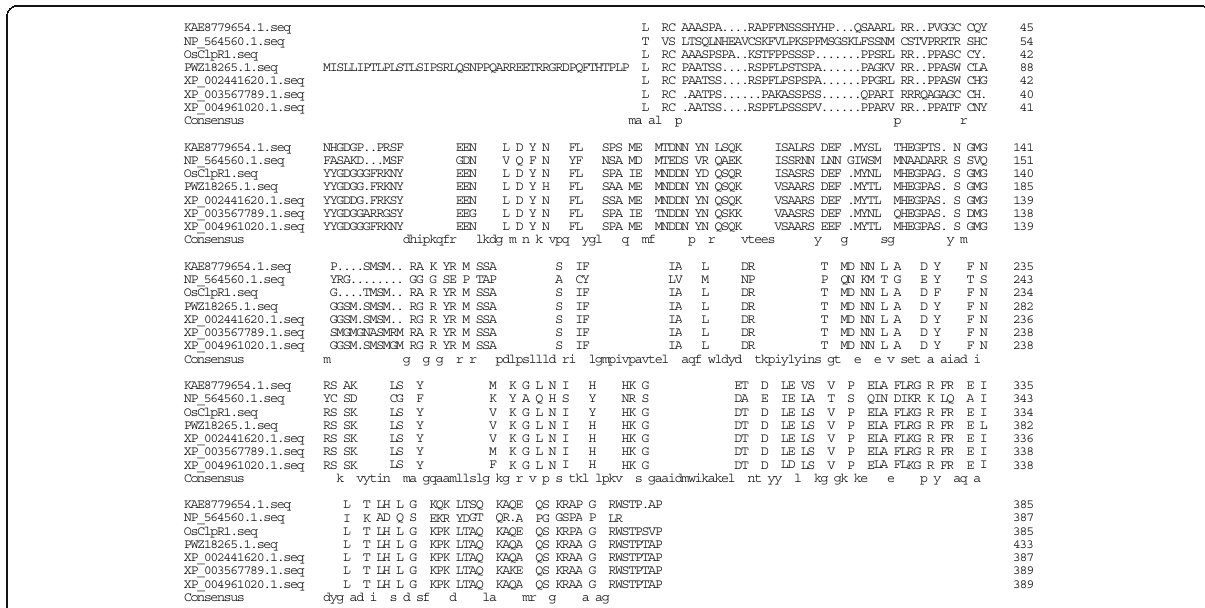
Fig. 4 Amino acid sequence alignment of OsClpR1 and its homologs PWZ18265.1 ( Zea mays ), XP_002441620.1 ( Sorghum bicolor ), XP_004961020.1 ( Setaria italica ), XP_003567789.1 ( Brachypodium distachyon ), KAE8779654.1 ( Hordeum vulgare ), NP_564560.1 ( Arabidopsis thaliana ). Amino acids that are fully or partially conserved are shaded black and pink, respectively